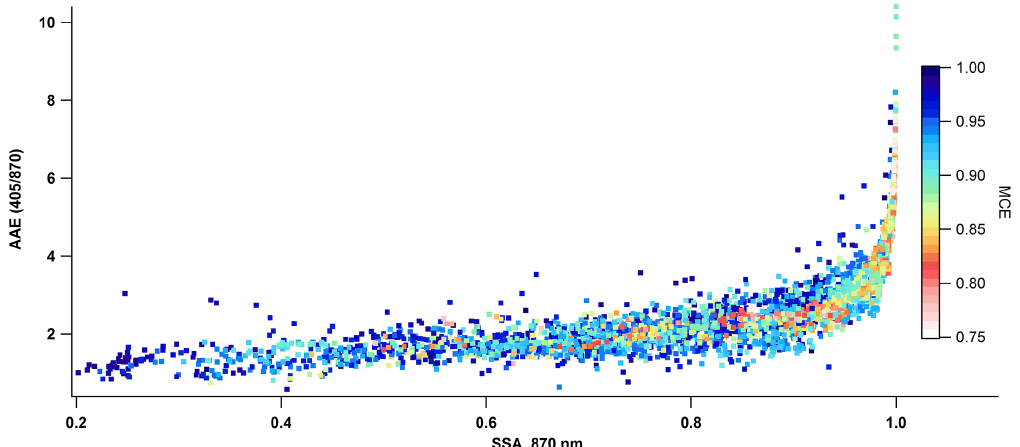
Figure 5. The AAE calculated at 405 and 870nm vs. SSA at 870nm for all crop residue burn samples measured every second during emissions collection. Each data point is colored by MCE. The AAE increases sharply at high SSA, while the MCE distinctly decreases at increasing SSA. BC emissions are associated mostly with high MCE flaming and BrC emissions are associated mostly with low MCE smoldering. Most source types demonstrated a similar